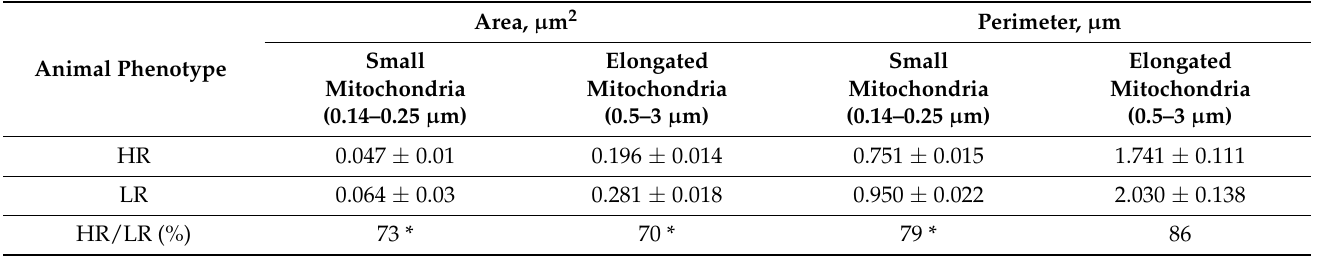
Table 3. Area and perimeter of small and elongated mitochondria in CC of HR and LR rats in